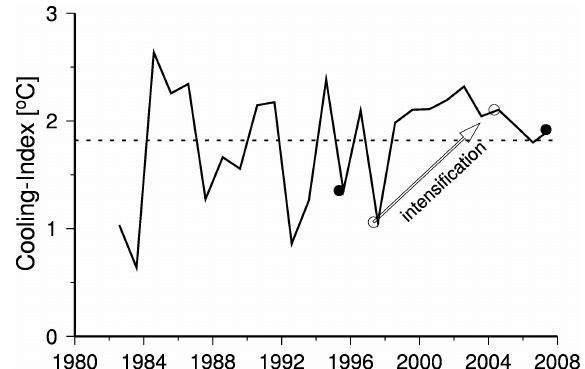
Figure 9. The cooling index calculated as SST difference between the spring intermonsoon and the SW monsoon. Data were obtained from Smith et al. (2008) and averaged for the upwelling-influenced western Arabian Sea between 13 and 23 ◦ N and 55 and 65 ◦ E. The dotted line shows the mean upwelling-driven cooling of 1.82 ◦ C, the black circles indicate the SW monsoons of 1995 and 2007, and open circles the SW monsoons of 1997 and 2004. The arrow indicates the periods during which Goes et al. (2005) obtained the data which lead to the assumption that global warming enhances the upwelling- driven productivity in the Arabian